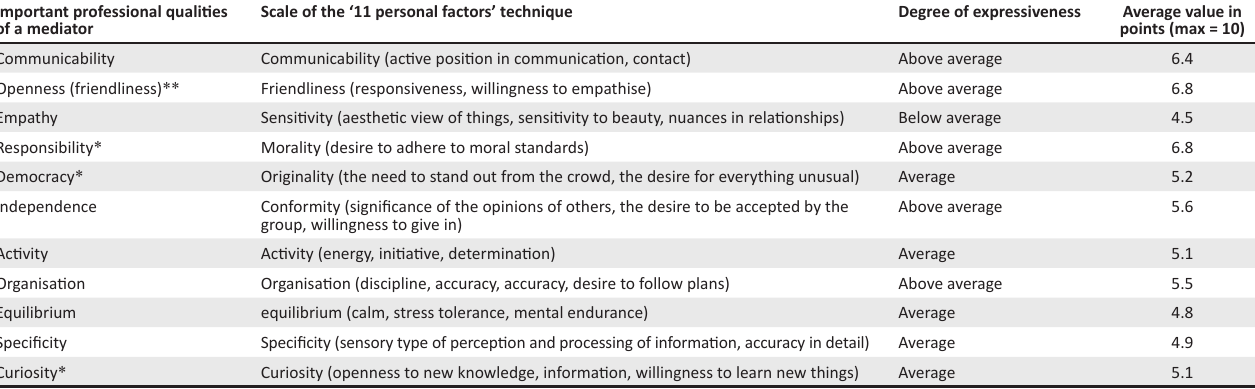
TABLE 4: The expressiveness of mediators’ important professional qualities based on the results of this study. Important professional qualities of a